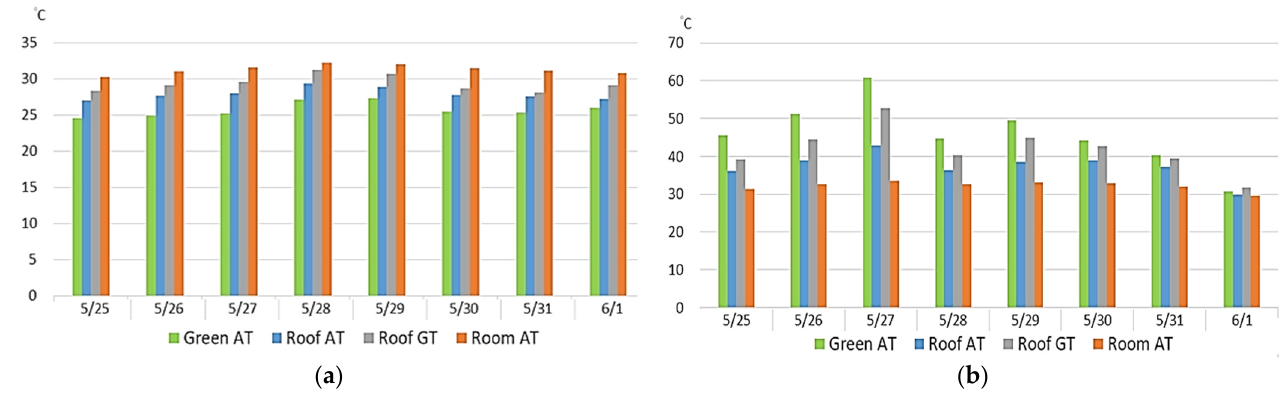
Table 6. Ambient temperatures of the ecological terrace during 04:00–05:00. Figure 8. Environmental effects of the ecological terrace during ( a ) 04:00–05:00 and ( b ) 12:00–13:00.